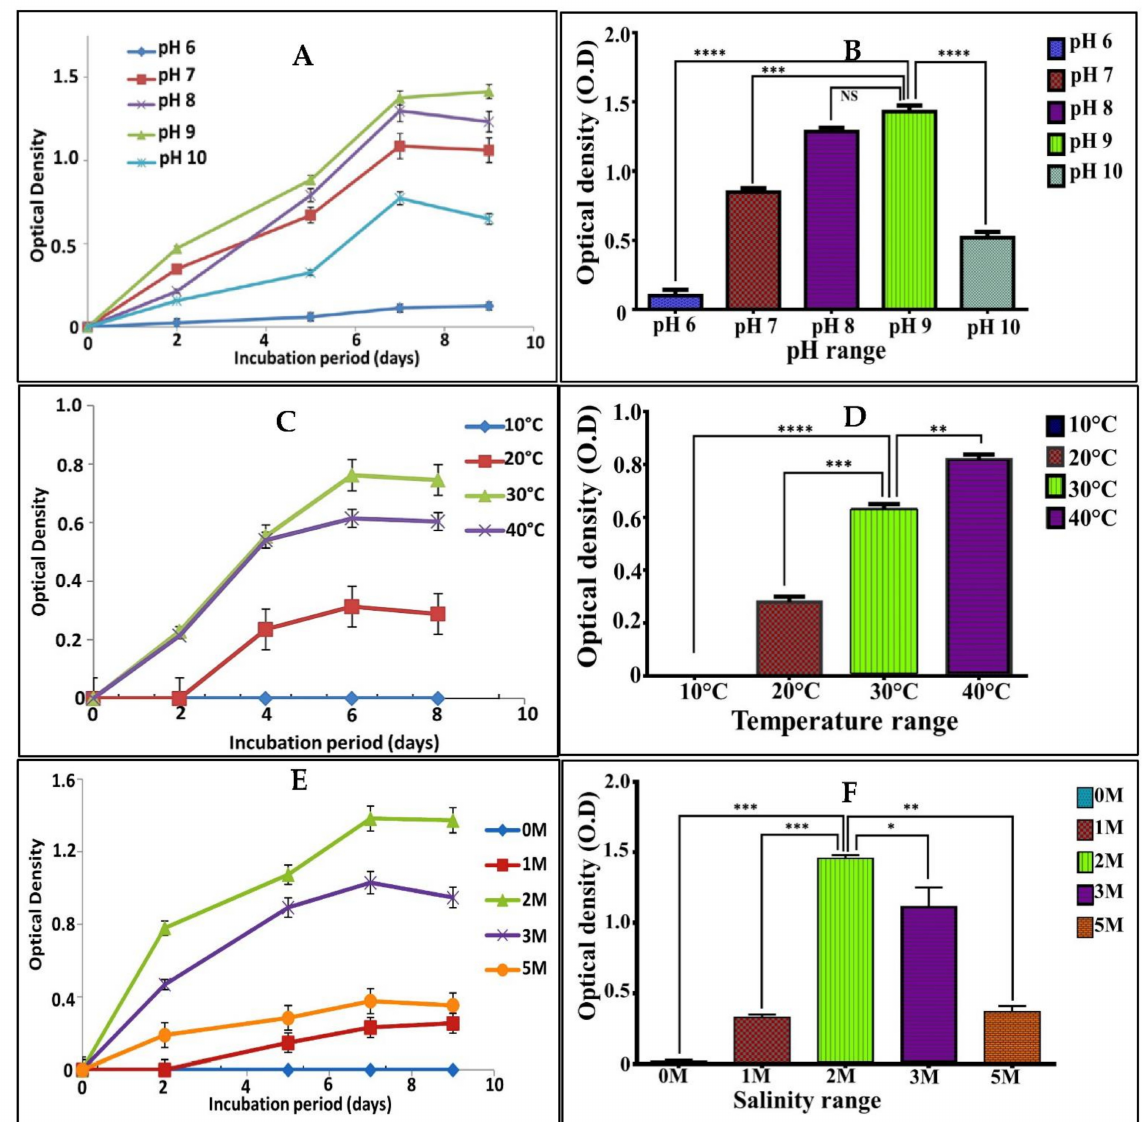
Figure 3. Physiological characteristics of V. halodenitrificans DASH during 9 days of incubation. ( A , B ) pH, ( C , D ) temperature and ( E , F ) different concentrations of NaCl. All values were expressed as mean ± SEM. This comparison considers significantly different at * p < 0.05, ** p < 0.005, *** p < 0.0005 and **** p < 0.0001, and NS (non-significant) as indicated by multiple comparisons Tukey post-hoc analysis of variance